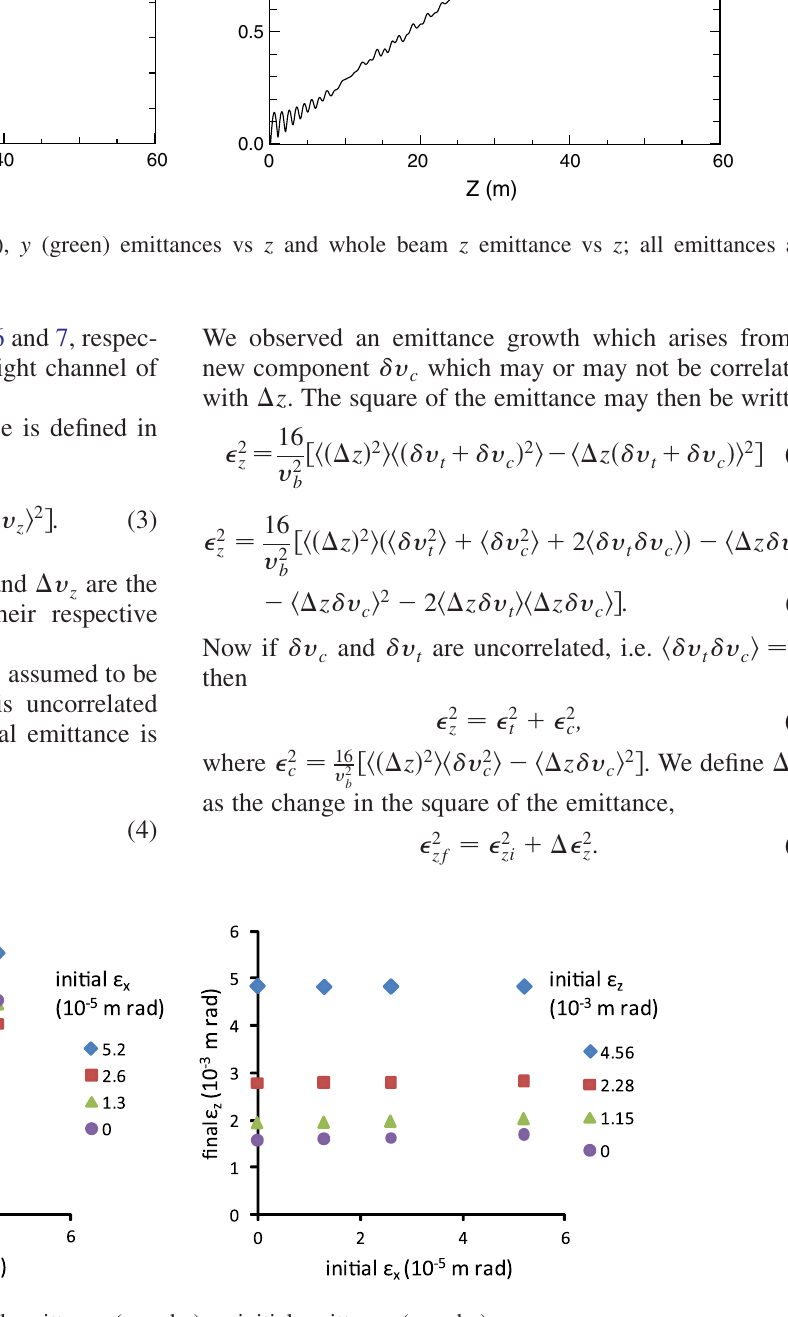
FIG. 6. Final emittance ( x and z ) vs initial emittance ( x and z